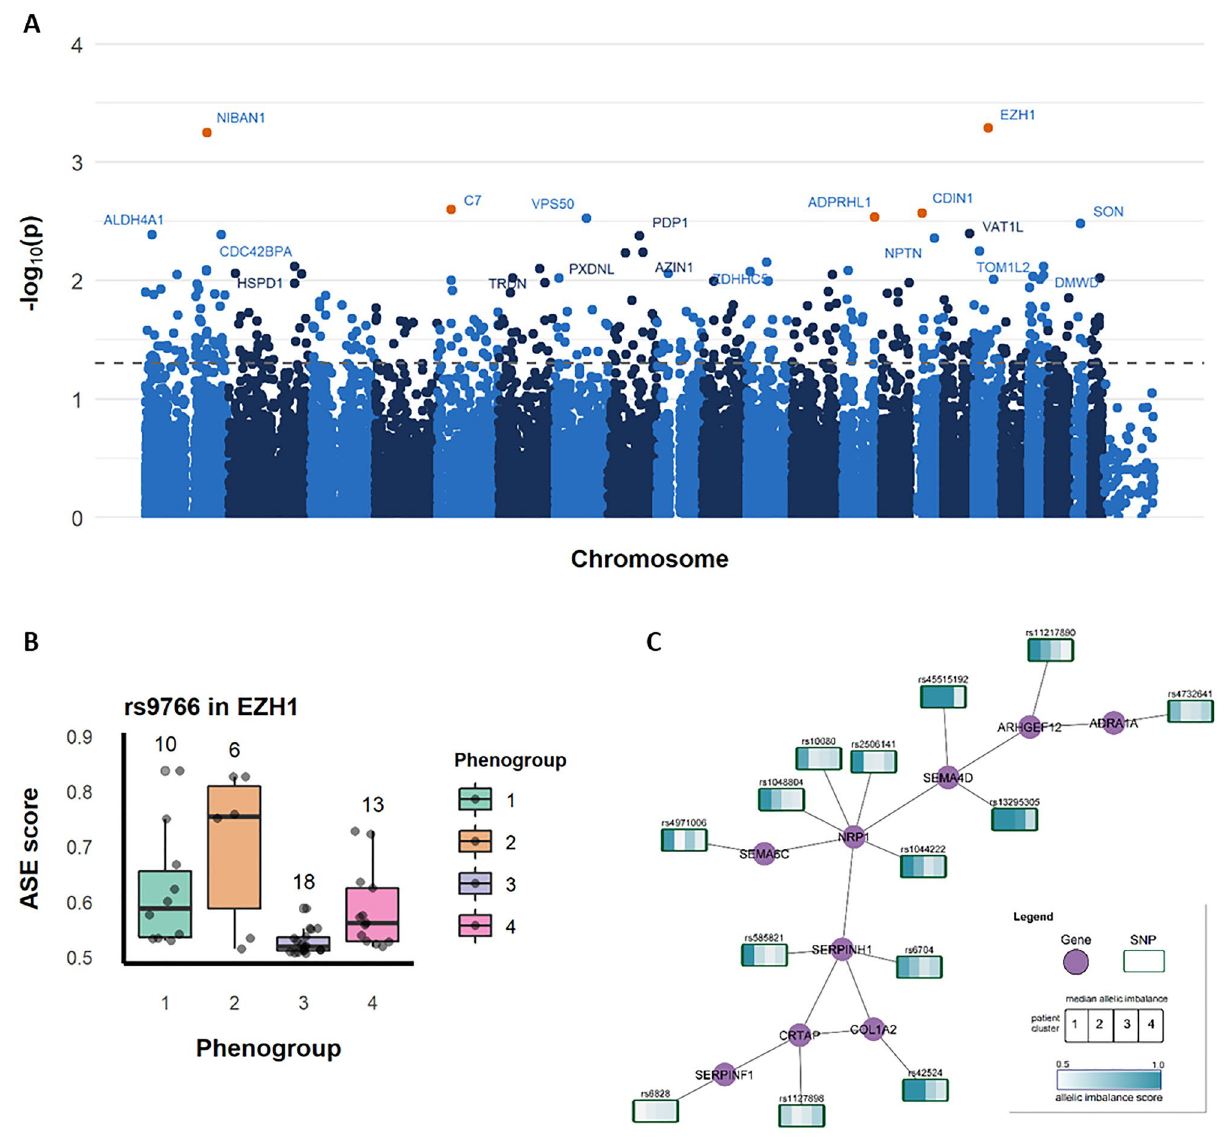
Figure 4. Overview of results visualizations for differential imbalance between all four phenogroups. ( A ) Manhattan plot indicating loci significantly differentially imbalanced between all four phenogroups. Note that each dot represents a SNP, annotated with the gene it is located in. ( B ) Boxplot showing the distribution of ASE scores and number of measurements by phenogroup for rs9766, located in EZH1, the most significant differentially imbalance SNP between the four phenogroups. ( C ) Subgraph of the network displaying a group of functionally related genes with median ASE scores for the corresponding SNP per